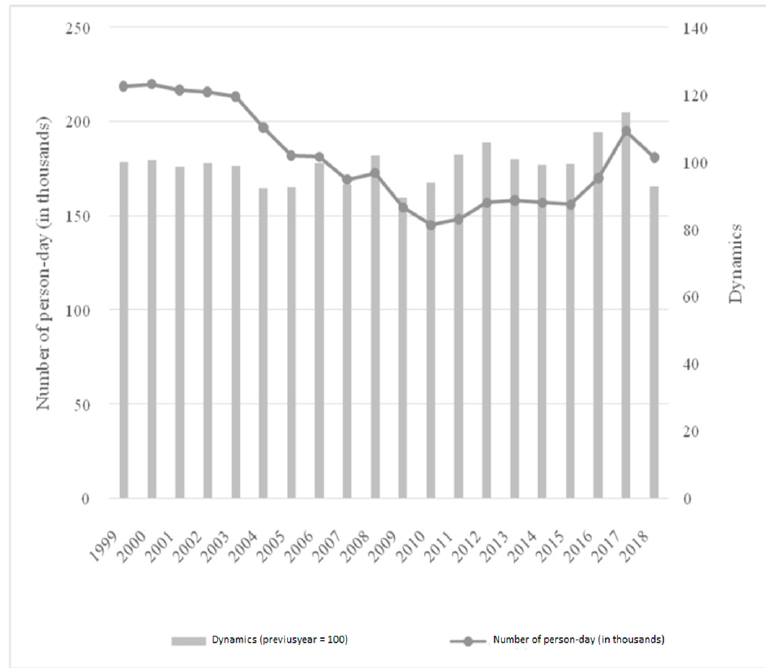
Figure 4. Person-days of patients in the analyzed hospital in 1999–2018.